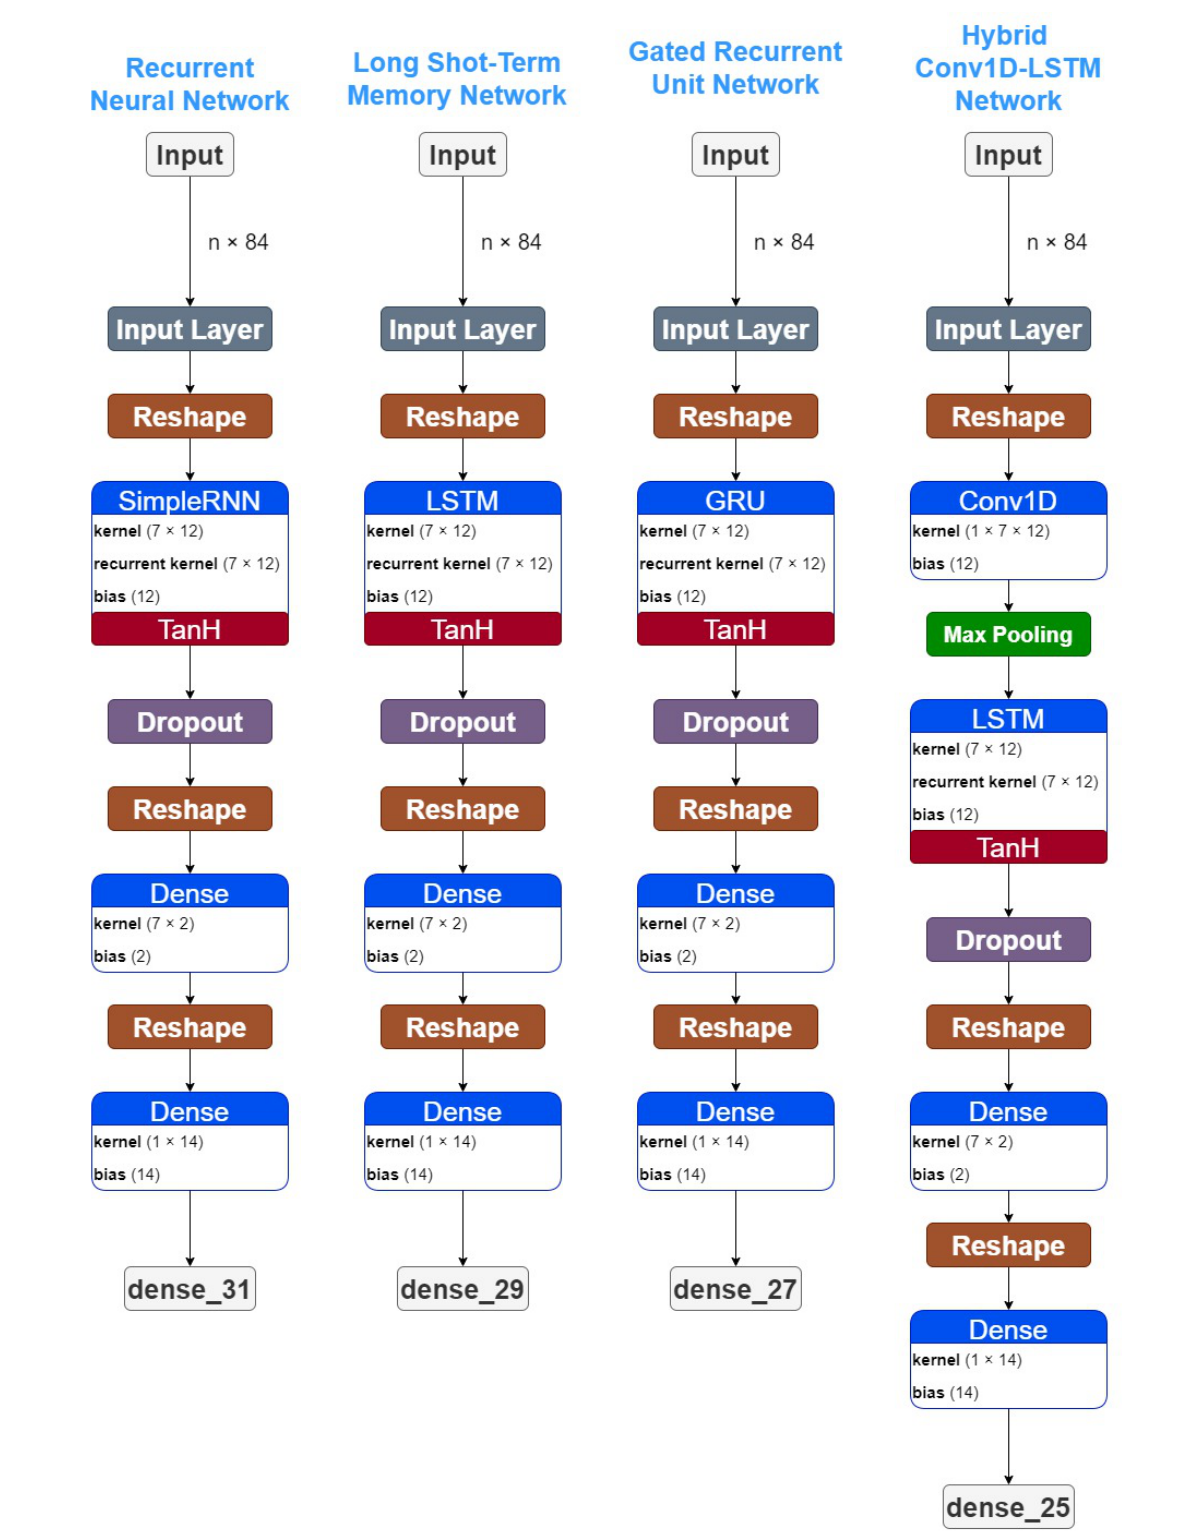
Figure 4. Deep learning architectures for COVID-19 predictions. The notation n is used for the n -th input that is ingested into the